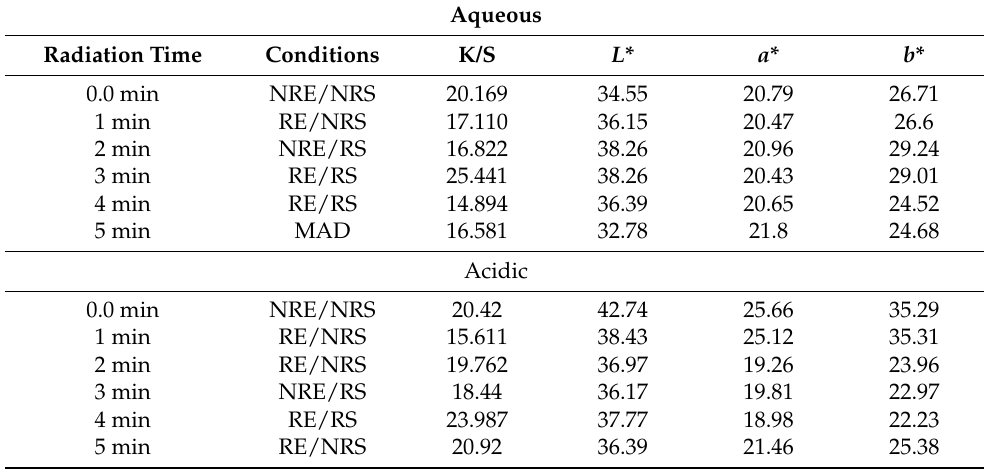
Table 1. Selected radiation and dyeing conditions for silk using red sandal powder